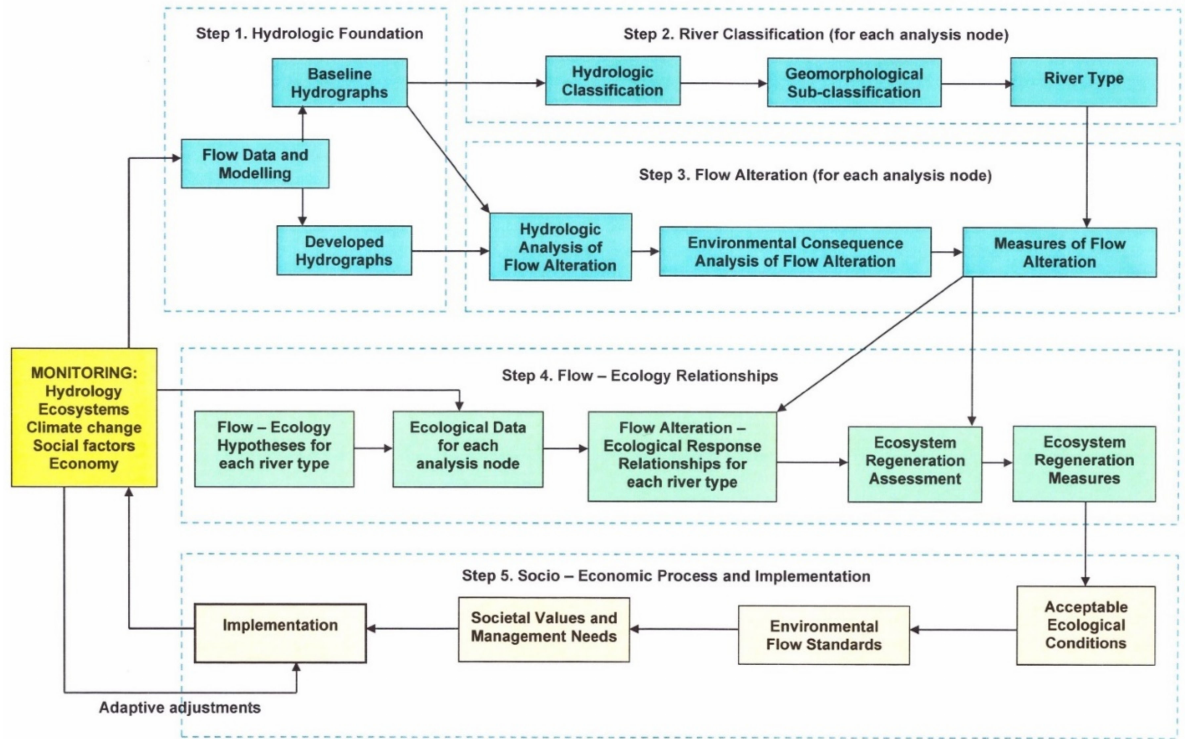
Figure 11. The concept of sustainable construction of inland waterways. The complex ELOHA method can be helpful in the construction of ecologically viable improvements of inland waterways but must be completed with the ecosystem approach Source: Modified and redrawn after